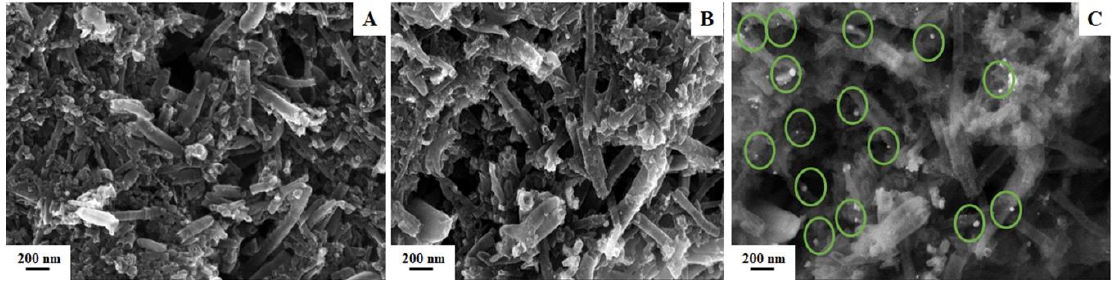
Figure 5. SEM InLens images of raw SPCNFE ( A ) and SPCNFE after the drop casting of Ag-NPs ( B ). SEM Secondary Lens of SPCNFE highlighting the location of the drop-casted Ag-NPs ( C ).